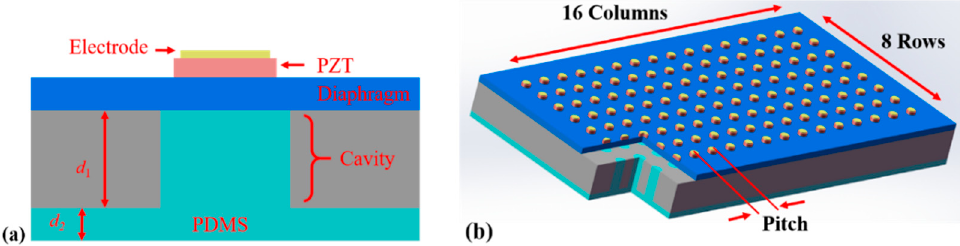
Figure 1. Schematic of backed piezoelectric micromachined ultrasonic transducers (B-PMUTs). ( a ) The designed structure of a single element. ( b ) Three-dimensional (3D) schematic of the array.